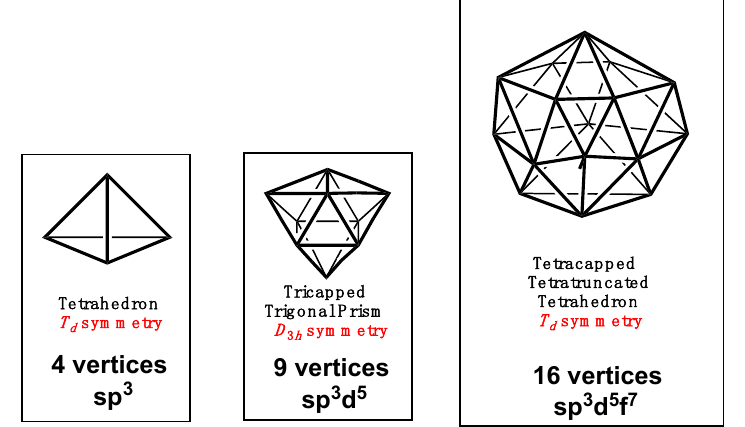
Figure 2. The most spherical deltahedra corresponding to filled 4-orbital sp 3 , 9-orbital sp 3 d 5 , and 16-orbital sp 3 d 5 f 7 manifolds.